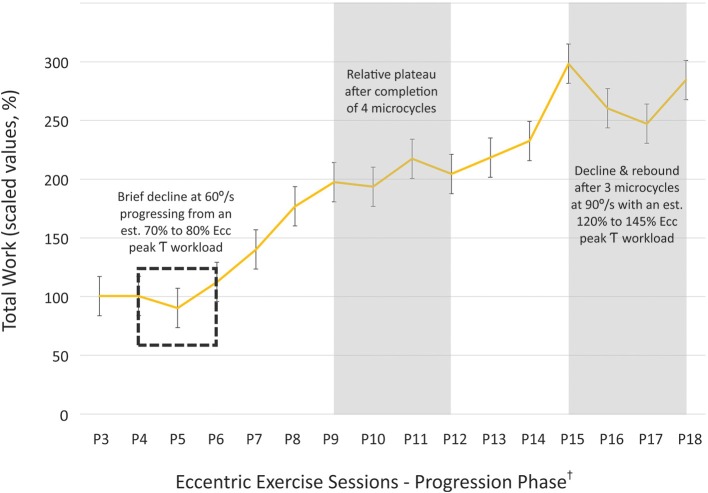
Adjusted total work values attained during the progression phase of the strength training program. Eccentric total work (60°/s) during the progression phase of the initial exercise program was indexed to the values attained at the start of the 5% workload increments during the fifth microcycle, and proportional change in the total work values was graphed until the end of the exercise program (†progression phase sessions 3 through 18; i.e., P3–P18). The total work increased from the index value of 100% to the final value of 285% at the end of the eccentric strength training regimen, and isolated periods of diminished exercise performance were identified as potential points in the exercise program suitable for an active recovery period. (τ, torque; error bars = SE, standard error).